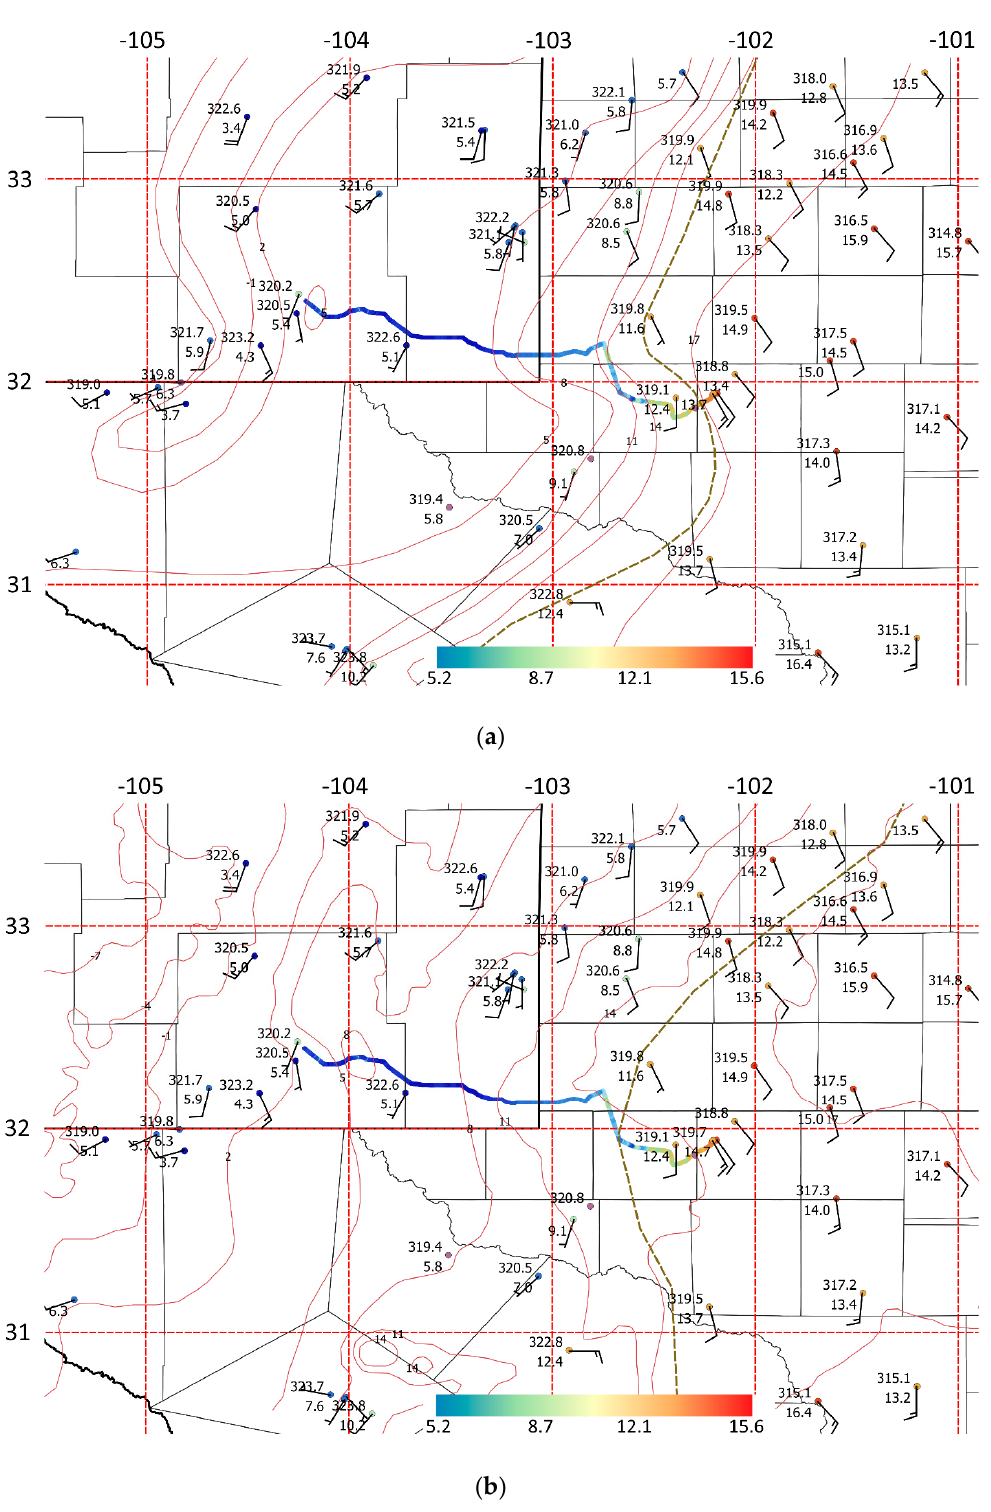
Figure 18. Surface observations ( 𝜃 𝑣 and mixing ratio) at 1900 UTC and mobile track mixing ratio (adjusted to 1900 UTC), compared with manual dew point and dryline analyses from ( a ) observations and ( b ) HRRR.